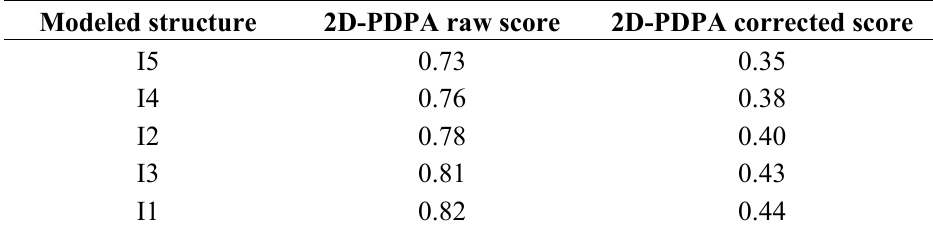
Table 7. 2D-PDPA scores for the five I-TASSER structures.